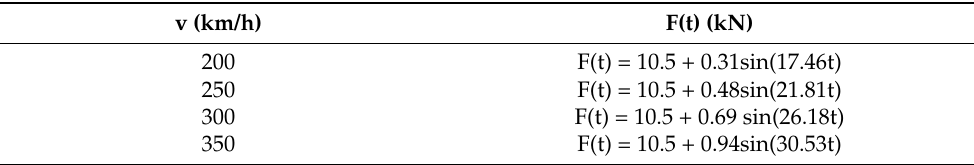
Figure 10. Vertical displacement distribution curves of surface soil at different distances from the fault and perpendicular to the high-speed railway line. ( a ) At different distances of the upper wall; ( b ) at different distances of the footwall.